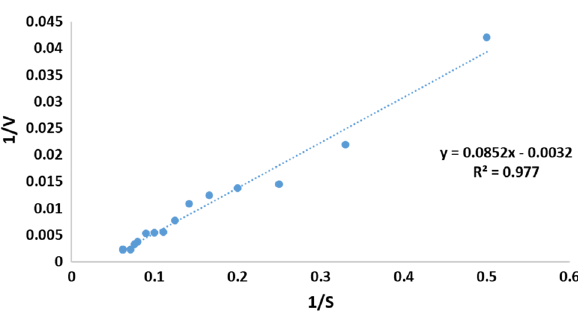
Figure 17. Line-weaver-Burk equation used for K m and V max calculation.